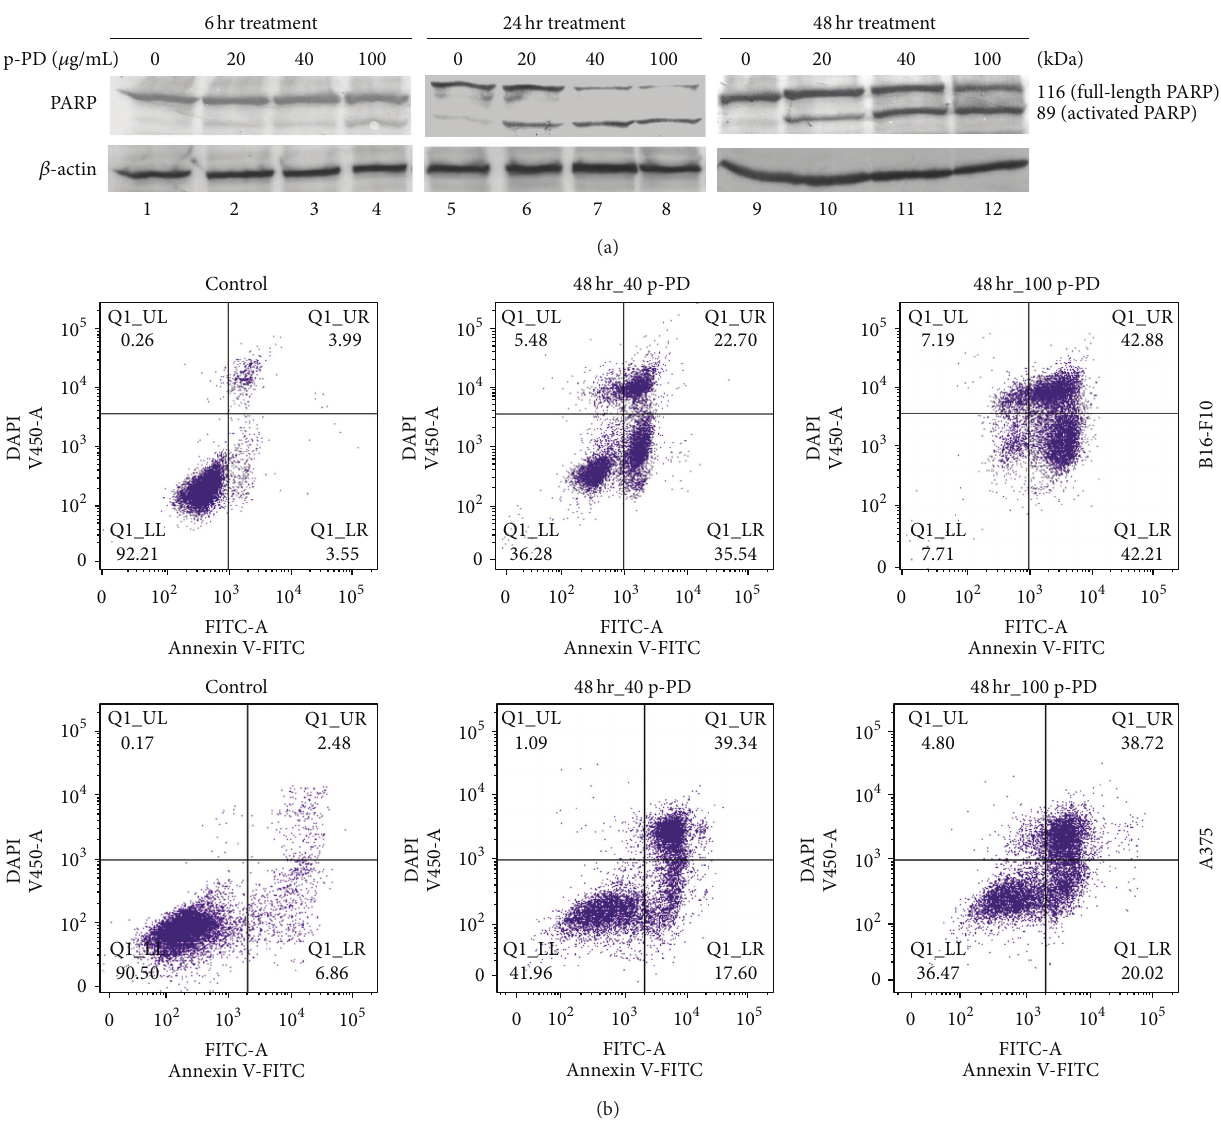
Figure 3: p-PD mediates apoptosis in melanoma cells. (a) A375 cells were treated with p-PD as indicated. After treatment, cells were lysed with protein loading buffer (Materials and Methods). 30 𝜇 g of total protein lysate was loaded in each lane and subjected to western blot and probed for activation of PARP. Cells that were not treated with p-PD (0) but with 0.1% DMSO served as control (lanes 1, 5, and 9). These blots are representative of three independent analyses. 𝛽 -actin is used as a loading control for all time points. (b) Both A375 and B16-F10 cells were treated for 48 hours with indicated amounts of p-PD and were subjected to flow cytometry analysis using Annexin V-FITC assay. DAPI was used as the DNA stain.